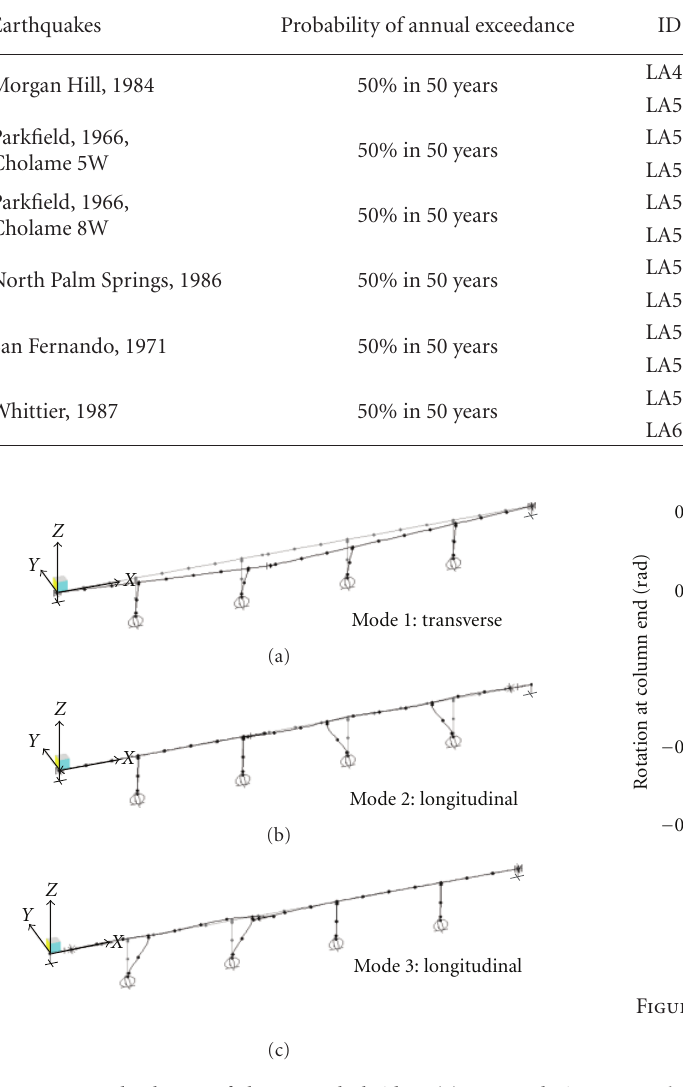
Figure 7: Mode shapes of the example bridge; (a) 1st mode in transverse ( y ) direction, (b) 2nd mode in longitudinal ( x ) direction, and (b) 3rd mode in longitudinal ( x ) direction.